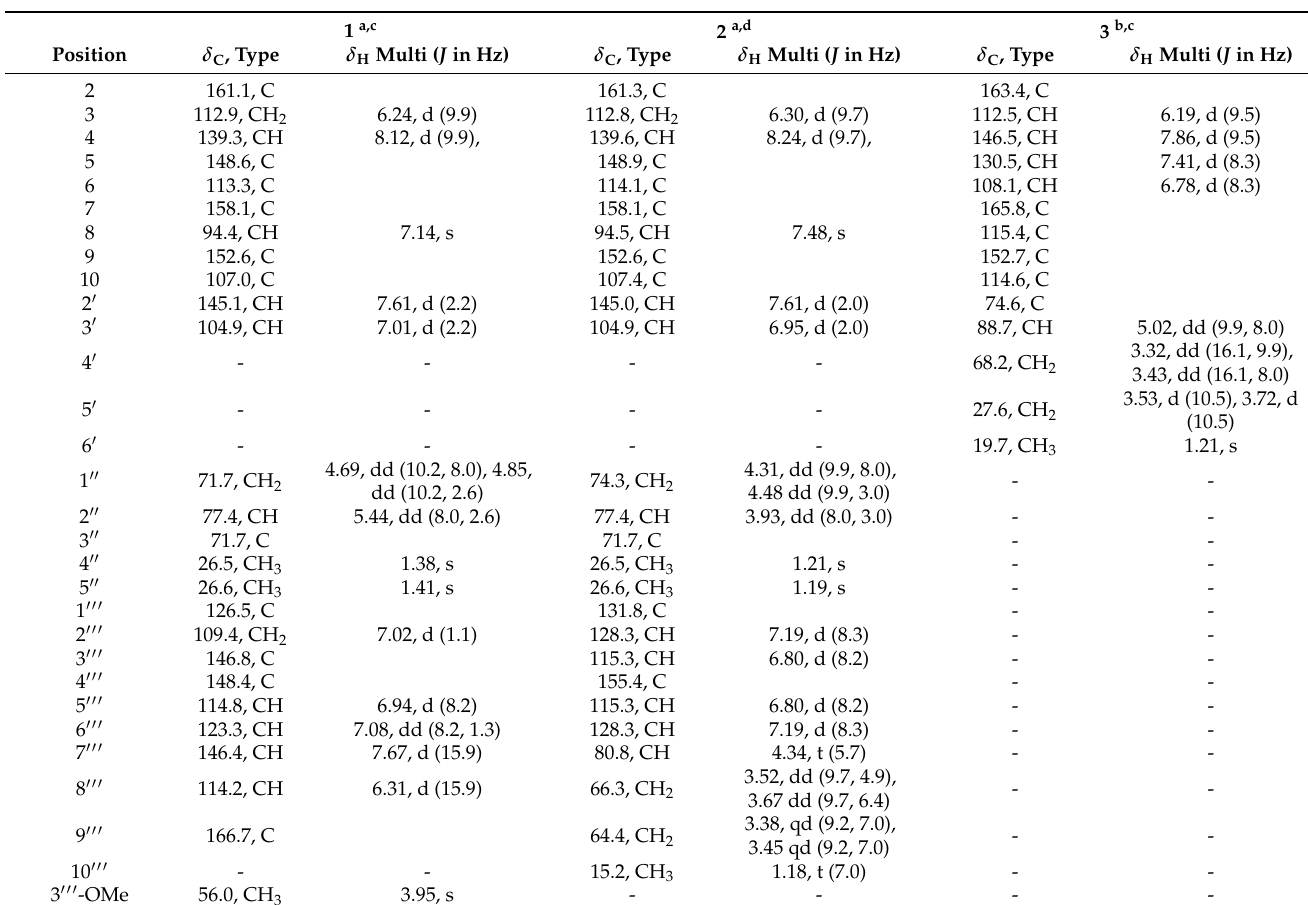
Table 1. 1 H and 13 C NMR data for new compounds 1 – 3 .